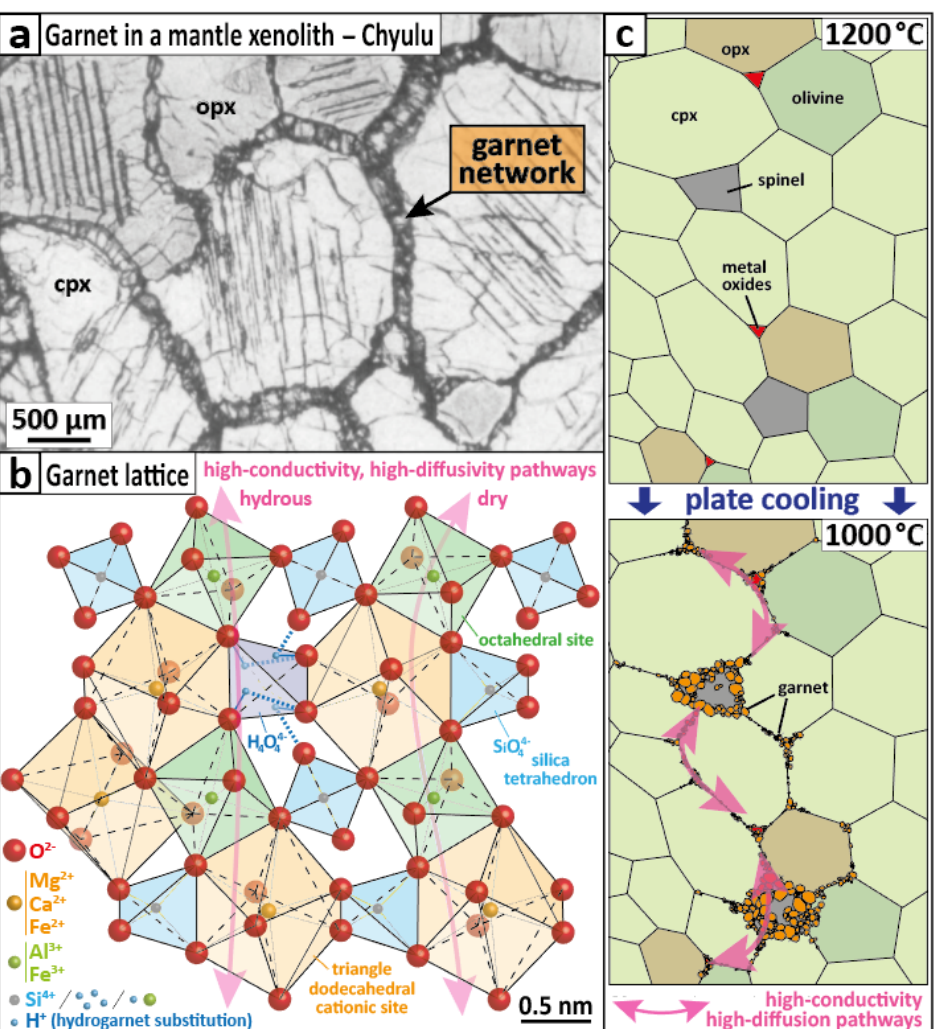
Figure 4. Garnet as a conductive phase in the mantle. ( a ) Natural garnet network in a mantle xenolith from Chyulu, Southern Kenya [26]. ( b ) Portion of the garnet structure (adapted from [37]) illustrating the e ff ect of hydrogarnet substitution [38], stabilized by hydrogen bonding [39], on electron pathways (pink). ( c ) Schematics of an example of the formation of a garnet network through a metamorphic reaction at grain boundaries at 2–3 GPa in a pyroxenite due to progressive plate cooling. As temperature decreases from 1200 to 1000 ◦ C, garnet networks can organize in pyroxene-rich zones, which could explain the conductivity anomaly o ff shore